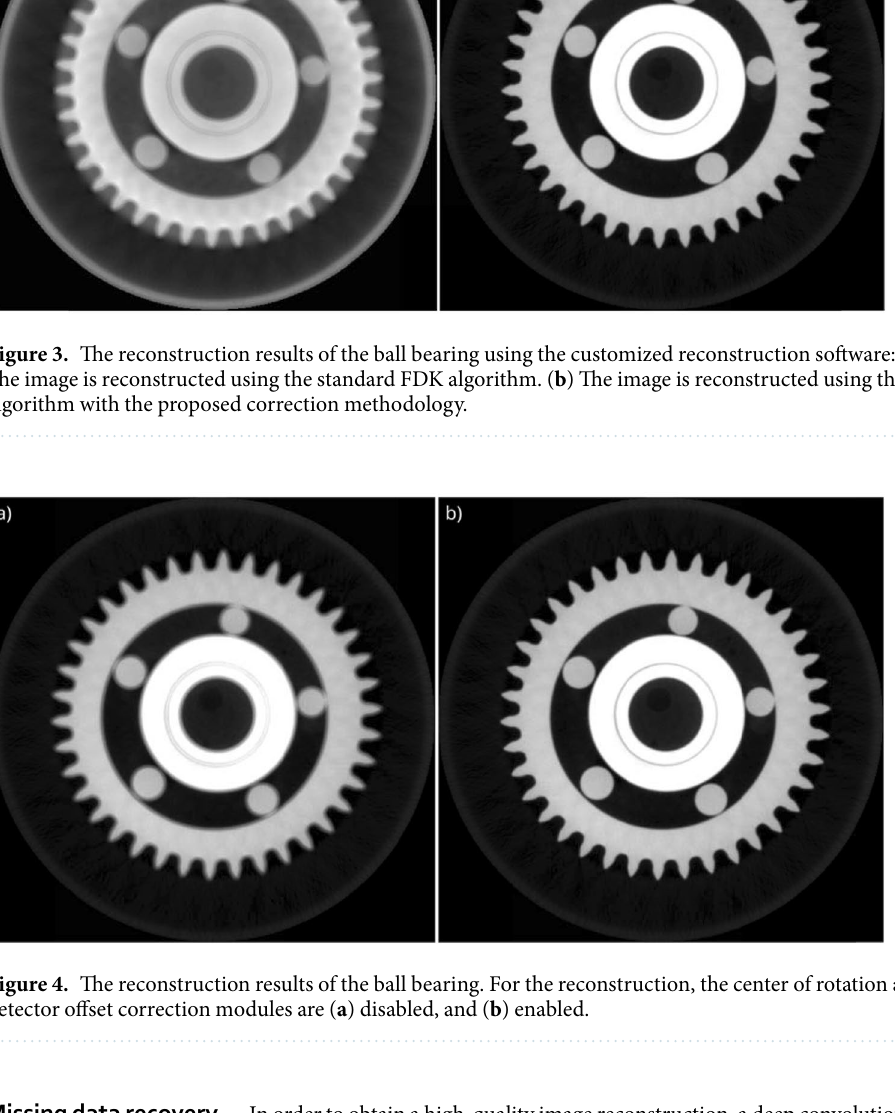
Missing data recovery. In order to obtain a high-quality image reconstruction, a deep convolutional neural network is used to suppress missing data artefacts on the reconstructed image, and eventually to get high-quality 3D reconstructed data from an incomplete set of projections. This novel methodology is applied to the identical ball bearing data for several data sets, e.g., for an angular coverages of 360° and 180°, respectively. Again, the data acquired from the ball bearing sample were not used for training or validation, and thus, it benchmarks the per- formance of the trained network. The as-detected and the artifact-corrected projections are compared in Fig. 7. This comparison shows that the proposed methodology effectively suppressed the missing data artefacts that are visible as streaks causing uneven intensity dissipation. The use of corrected projections within the proposed methodology increased the quality metric score from 45.8 to 43.1. Thus, the performance of the applied training model is proven by this validation test.